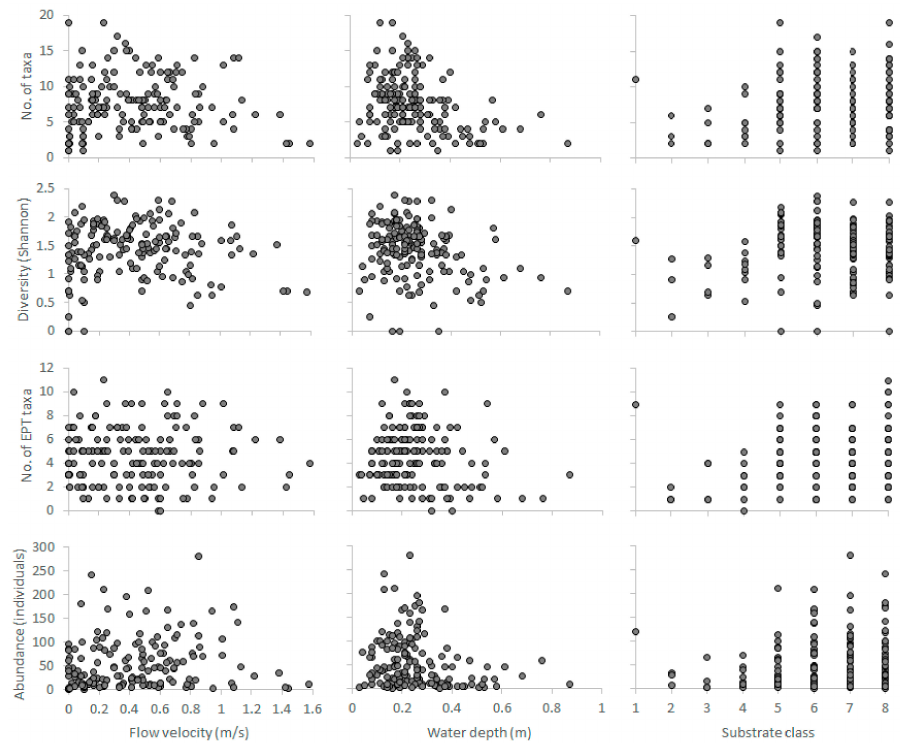
Figure A1. Hydroecological relationships developed from the spring samples ( n = 160) of the benthos-GR dataset between the three abiotic predictors and the four selected biotic response variables-metrics. Substrate classes; 1: Silt, 2: Sand, 3: Fine gravel, 4: Medium gravel, 5: Large gravel, 6: Small stones, 7: Large stones, 8: Boulders. EPT: Ephemeroptera, Plecoptera, Trichoptera.